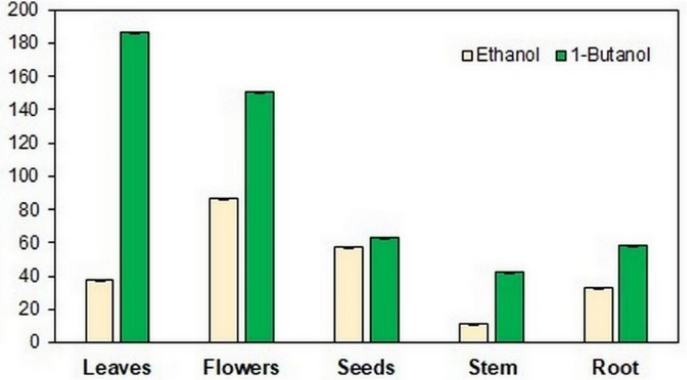
Figure 11. Concentration for scopolamine expressed as µ g g − 1 DW in Datura innoxia matrix extracts in ethanol and 1-butanol solvents.